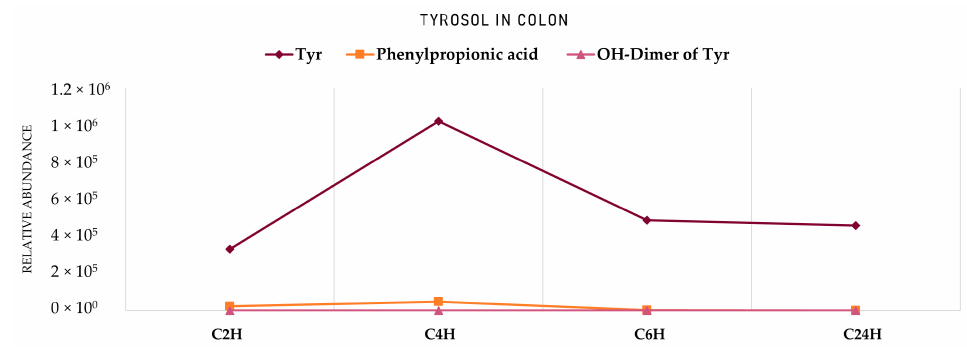
Figure 10. Area of HTyr metabolites in the colon. C2H : Colon T = 2 h; C4H : Colon T = 4 h; C6H : Colon T = 6 h; C24H : Colon T = 24 h. Tyr : Tyrosol; OH − Dimer of Tyr : Hydroxylated dimer of Tyr ( Tyr8